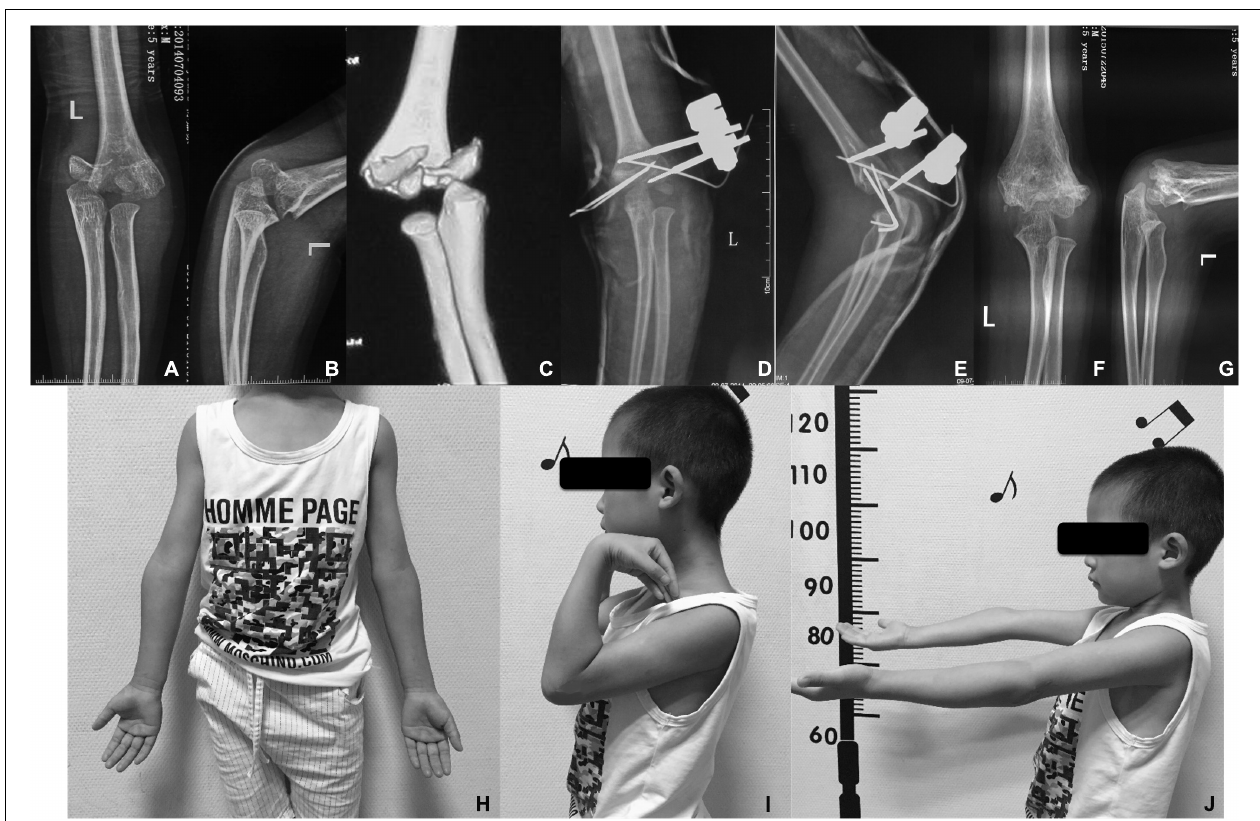
FIGURE 1 | (A) Anteroposterior and (B) lateral radiographs of a 6-year-old boy with an intercondylar fracture of the distal humerus; (C) CT scan showing C1 type of AO classification; (D) anteroposterior and (E) lateral radiographs post-operation; (F) anteroposterior and (G) lateral radiographs at 12 months post-operation; and the follow-up in 24 months after surgery show excellent cosmetic results (H) and the functional appearance (I,J)